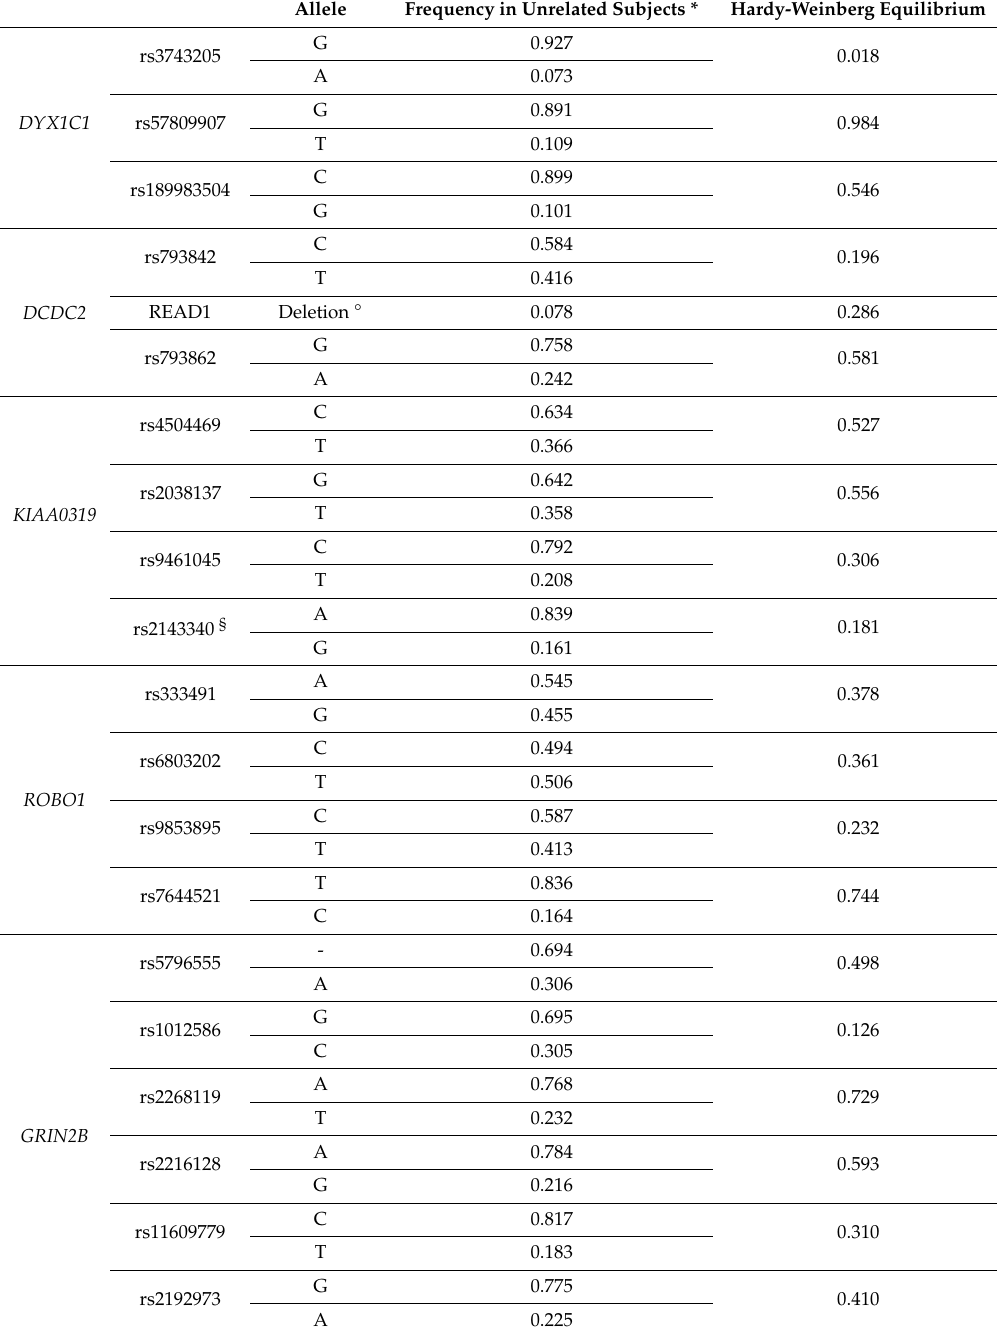
Table 1. Allele frequencies and Hardy-Weinberg equilibrium’s p -values. Allele Frequency in Unrelated Subjects * Hardy-Weinberg